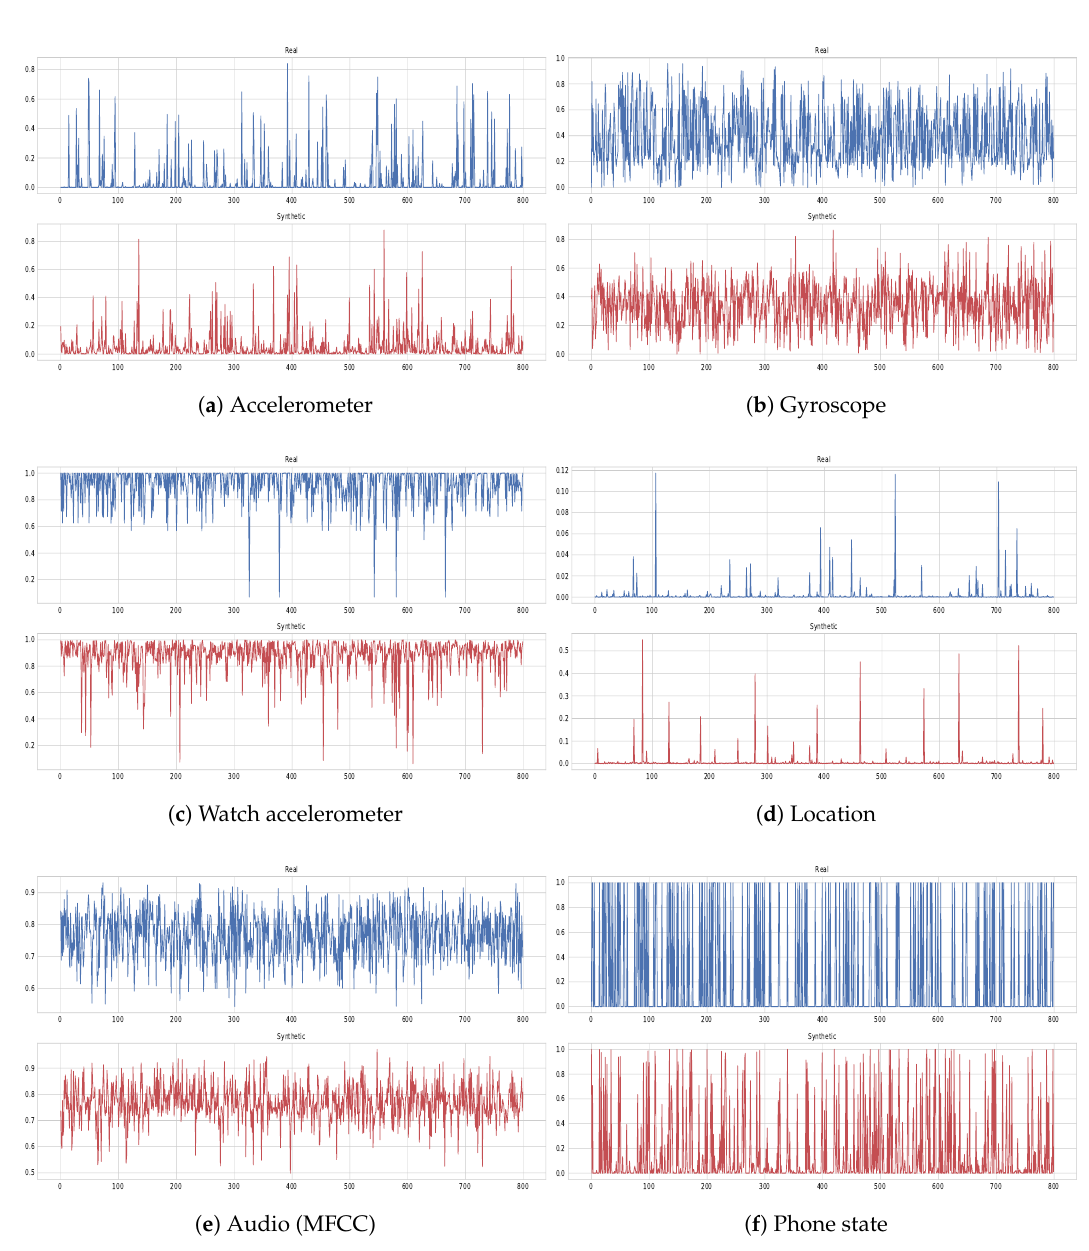
Figure 13. Examples of real (blue, top ) and generated (red, bottom ) samples of a randomly selected feature with